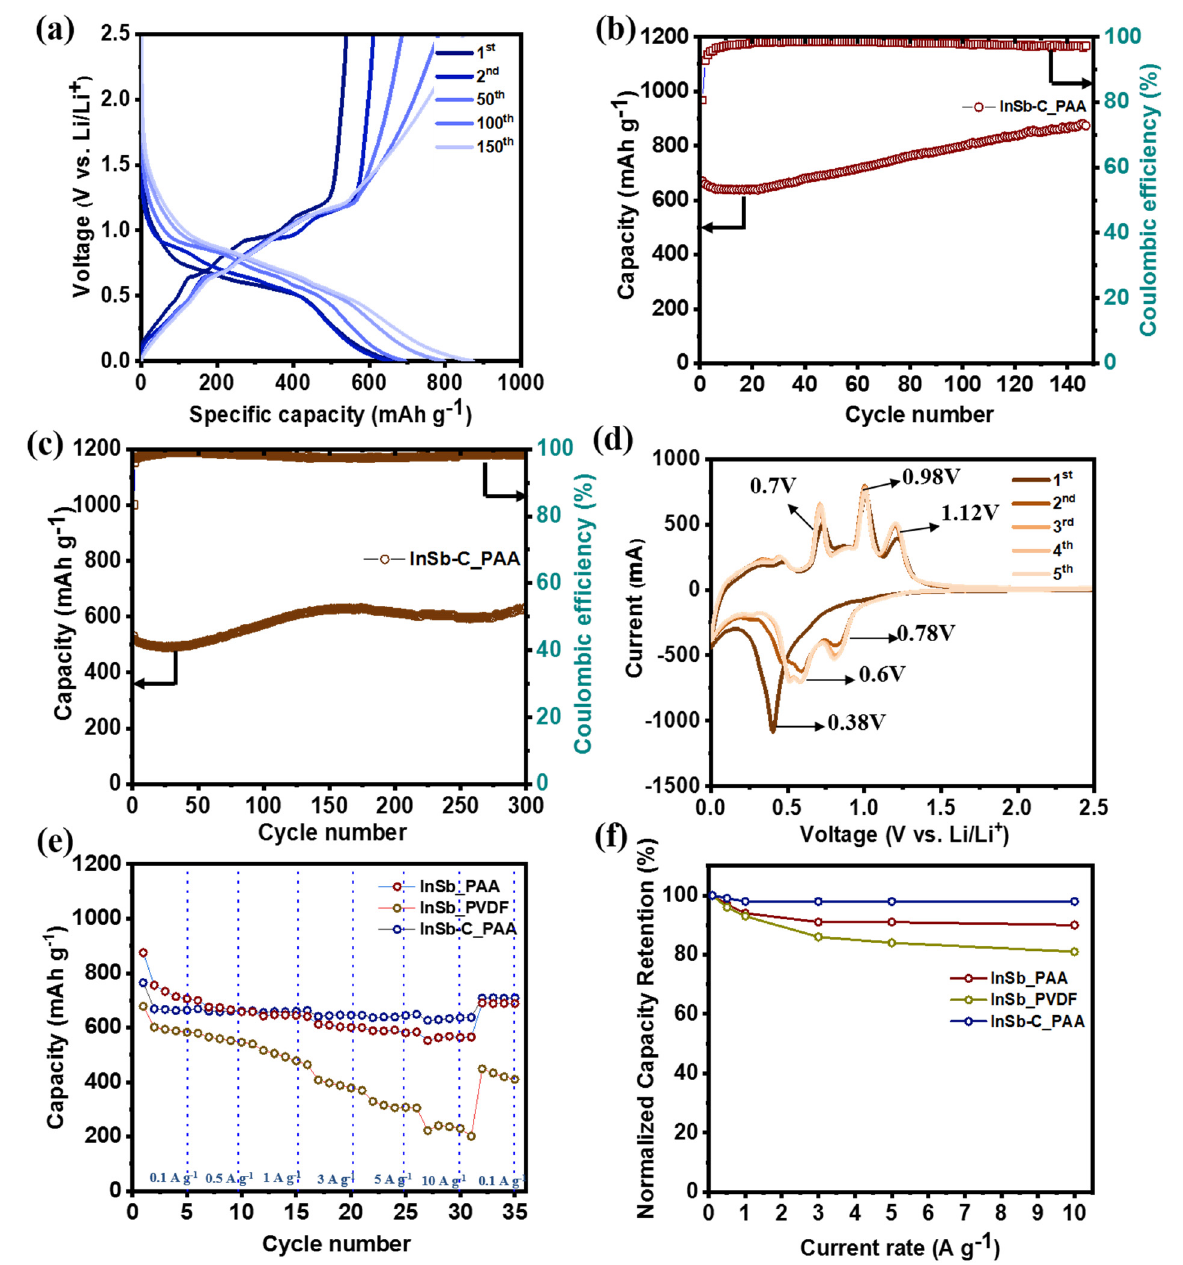
Figure 6. Electrochemical performance of the half-cells. ( a ) GCD profiles of InSb-C_PAA at a current density of 100 mA · g − 1 , cyclic performance of InSb-C_PAA at ( b ) 100 mA · g − 1 and ( c ) 500 mA · g − 1 , ( d ) CV curves of InSb-C_PAA, ( e ) rate capabilities of the composites, and ( f ) capacity retention of the composites at different current densities. EIS profiles of the InSb_PAA, InSb_PVDF, and InSb–C_PAA electrodes were ob- tained at the 1st, 5th, and 20th cycles (Figure 7). The electrolyte resistance (R b ), SEI layer resistance (R SEI ), charge-transfer resistance (R ct ), interfacial double layer capacitance (C dl ), constant phase element (C PE ), and Warburg impedance (Z w ) are all included in the simpli- fied equivalent circuit depicted in Figure 7a. The compressed semi-circles in the mid-fre- quency region of the Nyquist plots correspond to R ct at the electrode–electrolyte interface. The cells containing the electrode with the PAA binder (InSb_PAA and InSb–C_PAA) showed decreasing semicircles in the low-frequency region with an increase in the cycle number (from 1 to 20 cycles), indicating a gradual decrease in R ct and steady stabilization